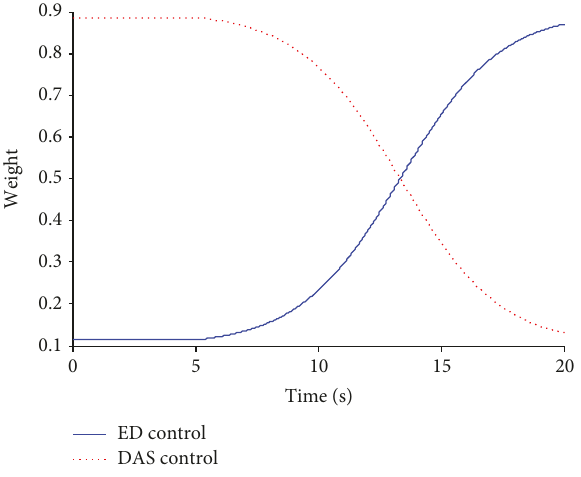
Figure 18: Weight coe ffi cient.